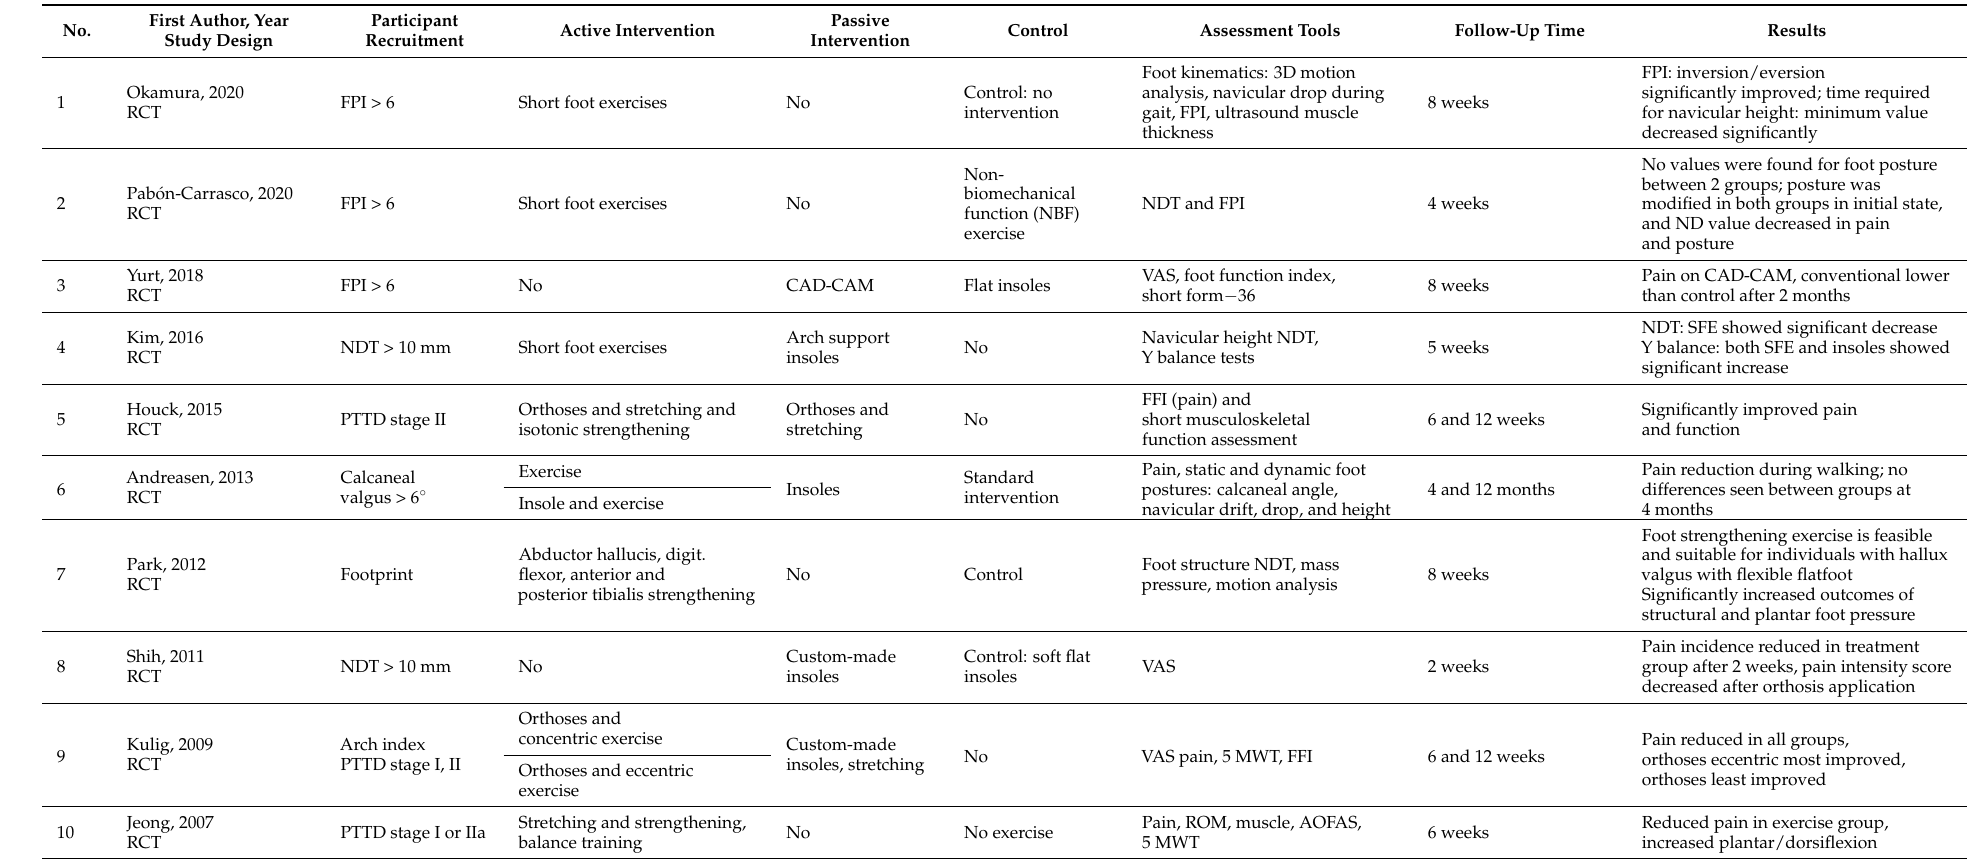
Table 2. Descriptions of included